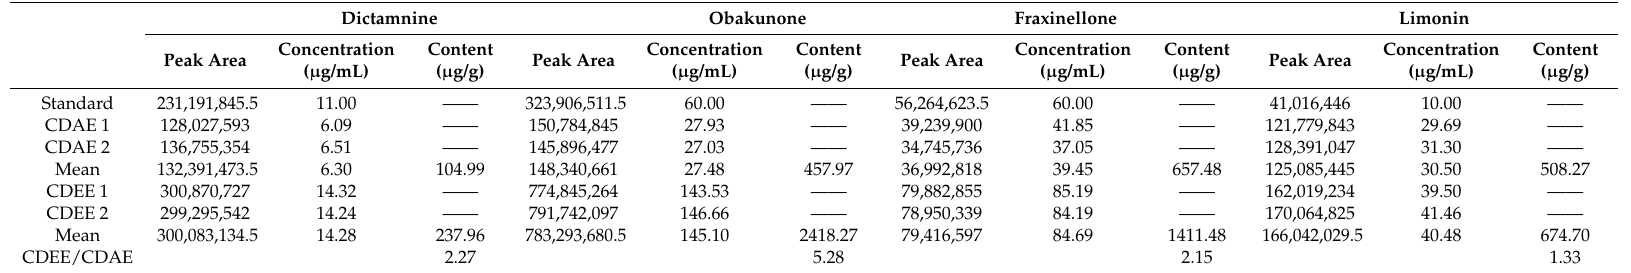
Figure 3. Positive ion model diagram of CDEE ( A ) and CDAE ( B ). 1. Dictamnine 2. Limonin 3. Obakunone 4. Fraxinellone. Table 4. Comparison of contents of dictamnine, obakunone, fraxinellone, and limonin in CDAE and CDEE.